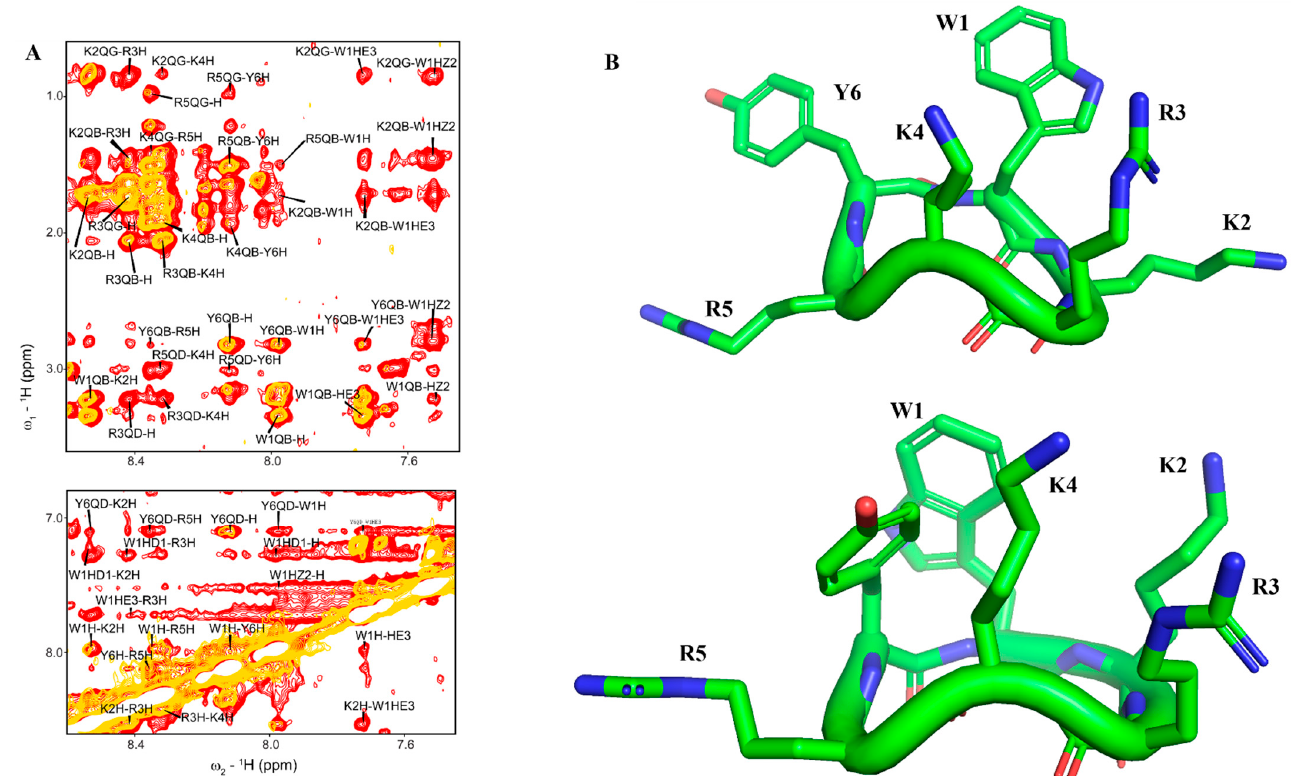
Figure 1. ( A ) Overlay of 1 H − 1 H two-dimensional NOESY (yellow) and tr − NOESY (red) spectra of cWY6 in free solution (yellow) and in the presence of LPS micelle (red) showing NOEs among amide protons and aromatic resonances (bottom panel) and amide/aromatic resonances with aliphatic resonances (upper panel). ( B ) 3 − D structures of cWY6 in free solution (upper panel) and in complex with LPS micelle (lower panel) represented by stick model. For cWY6, carbon atoms are in green, oxygen atoms are in red and nitrogen atoms are in blue.